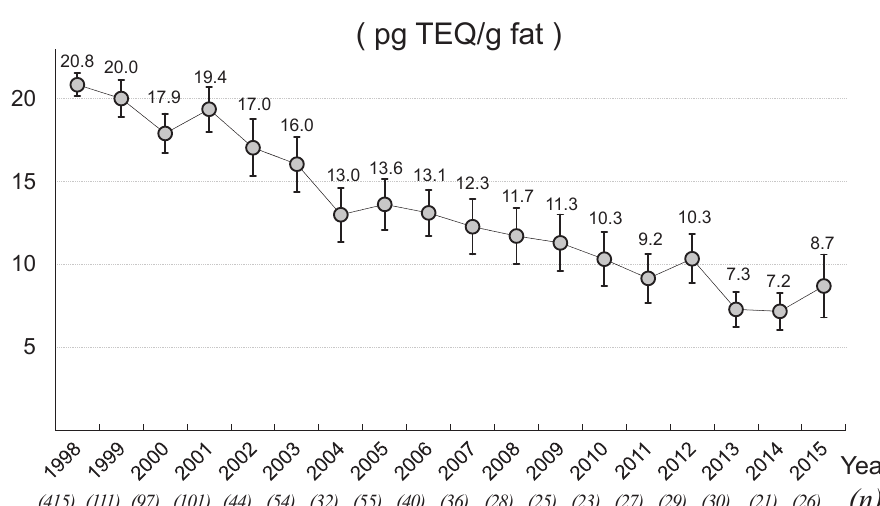
Figure 2. Annual trends in levels of total dioxins, 1998 – 2015. Total dioxins = PCDDs (7 isomers) + PCDFs (10 isomers) + coplanar PCBs (12 isomers). Annual levels of the total dioxins are shown with the means and 95% con fi dence intervals during the study period (1998 – 2015). Each value given in parentheses under the calendar year represents the sample size in each